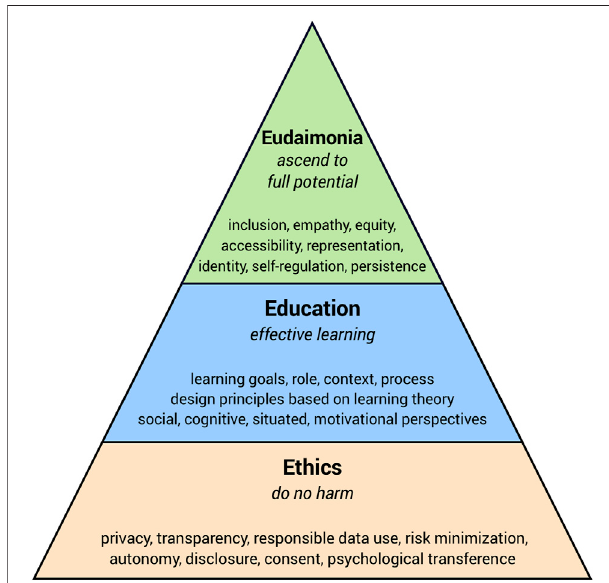
FIGURE 3 | Basic overview of the E3XR